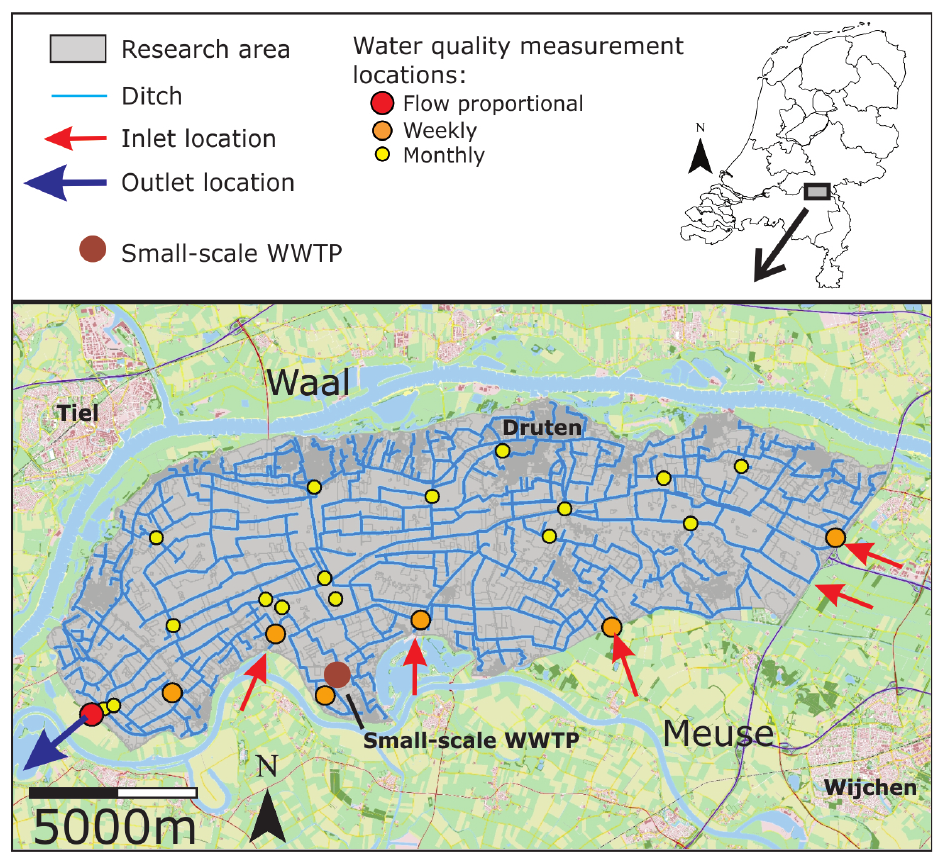
Fig. 1. Study area Quarles van Ufford with the inlet locations and the outlet, the main ditches, a small-scale waste water treatment plant (WWTP), and the water quality monitoring